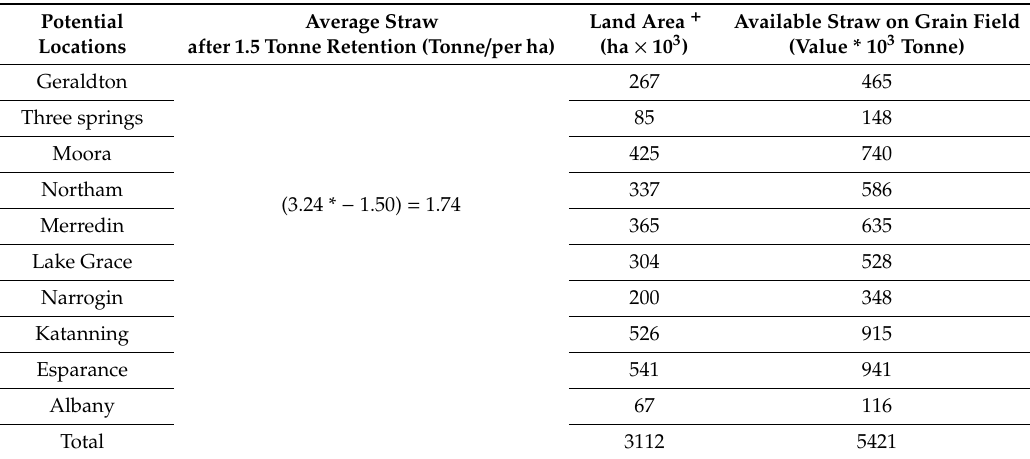
Table 1. Estimation of straw for